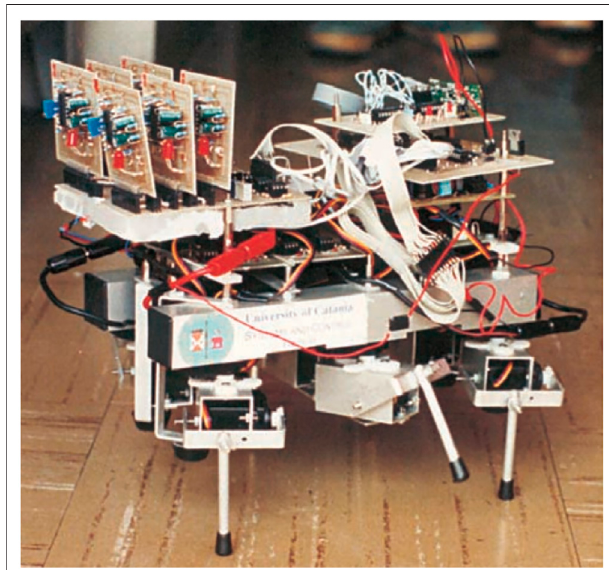
FIGURE 5 | Rexabot: the Reaction-Diffusion walking hexapod. Each leg has two degrees of freedom, each actuated by a servomotor. The robot kinematics is designed so that both leg joints can be driven by the same output of a CNN cell. Motion coordination among the legs is obtained at the level of the